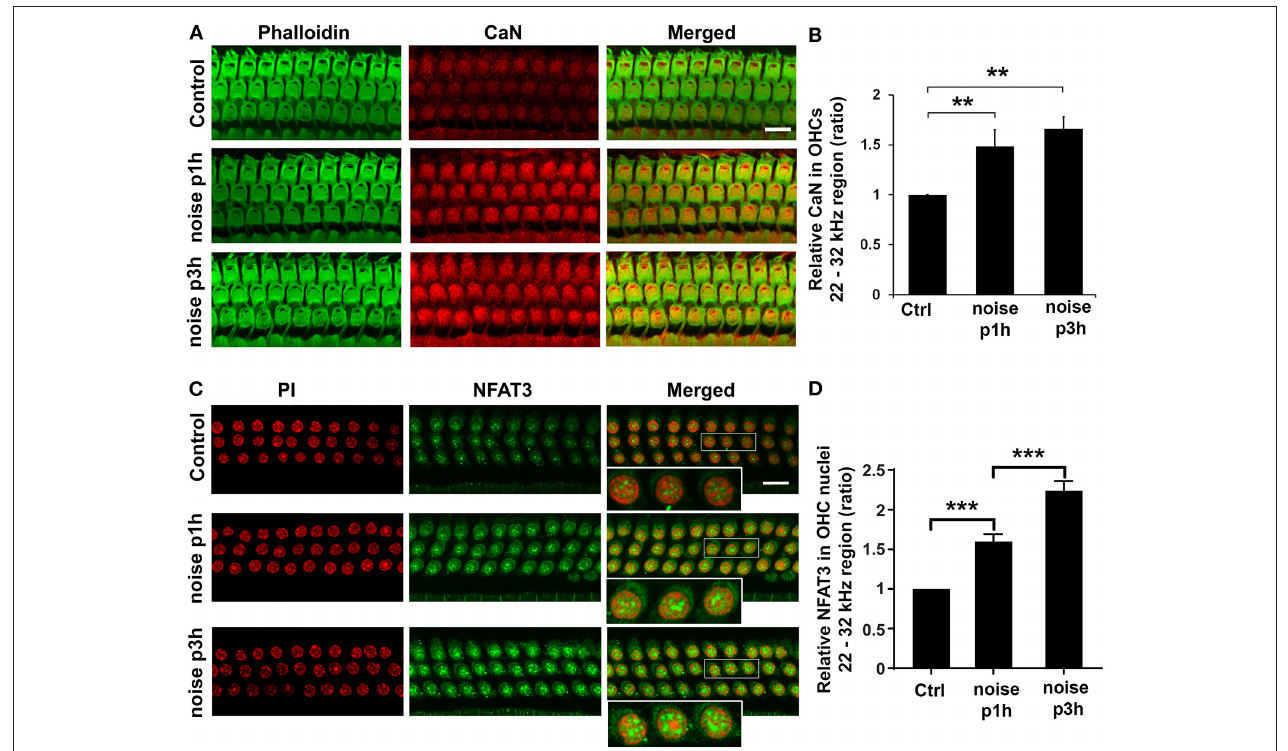
FIGURE 1 | Noise exposure increases CaN in outer hair cells (OHCs) and NFAT3 in OHC nuclei. (A) Surface preparations of the cochlear epithelium show that immunolabeling for CaN (red) in OHCs was stronger in noise-exposed mice examined 1 and 3h after the completion of exposure compared to control mice without exposure. Green, phalloidin-labeled sensory hair cells. Images were taken from the basal turn corresponding to sensitivity to 22–32kHz, and each figure is representative of five individual mice for each condition. Scale bar = 10 µ m. (B) Quantification of relative CaN immunolabeling intensity in grayscale in OHCs normalized to control mice confirms significant increases. Data are presented as means ± SD; n = 5 for each condition with one ear analyzed per mouse; ** p < 0.01. (C) Surface preparations show that NFAT3 immunolabeling was stronger in OHC nuclei 1h after, followed by an even greater increase 3h after exposure. For better visualization, three OHC nuclei were enlarged of the merged panels. This figure is representative of one ear per mouse in five individual mice in each group. Scale bar = 10 µ m. (D) Quantification of NFAT3 immunolabeling intensity in grayscale in OHC nuclei confirms a significant increase 1h after and a further increase 3h after exposure. Data are presented as means ± SD; n = 5 for each condition, *** p <